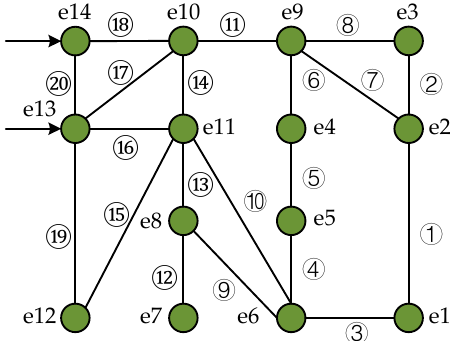
Figure A1. The topology of the 14-node receiving-end electricity network. Table A1. The electricity load of each node at t = 18.